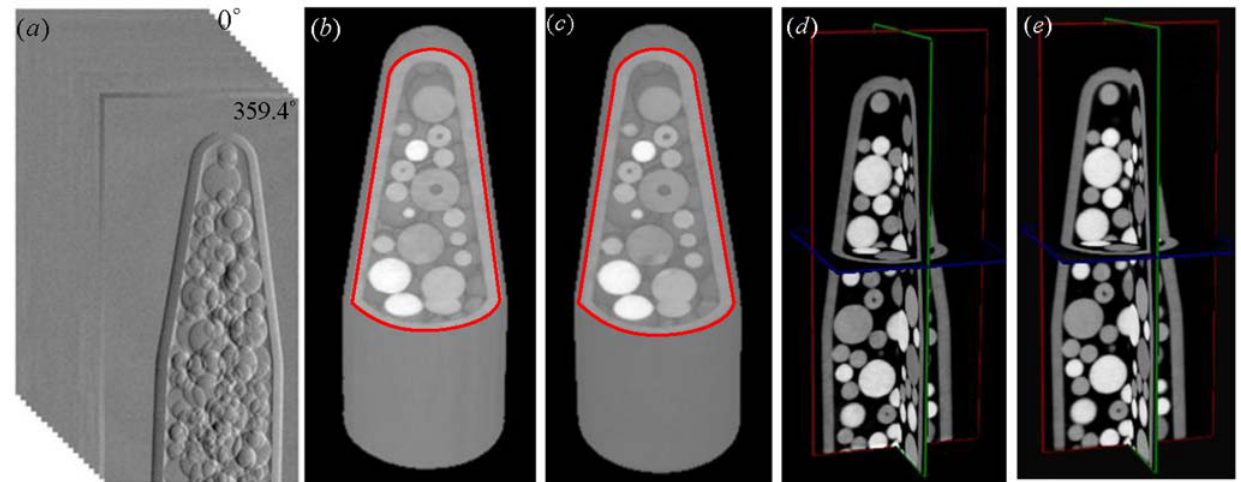
Fig 4. 3D reconstruction results of the sample. (a) displays a stack of 2D differential phase contrast projections retrieved from the recorded moiré fringe images by detector. (b), (c) and (d), (e) present the 3D volume rendering and the 3D orthogonal views of the results respectively. (b), (d) and (c), (e) correspond to the results reconstructed by AIR and FDK algorithms respectively. We cut some part of the sample, which is indicated by the red solid curves, to show the internal structure. The relax coefficient is set to be 0.8 and the number of the overall iteration is